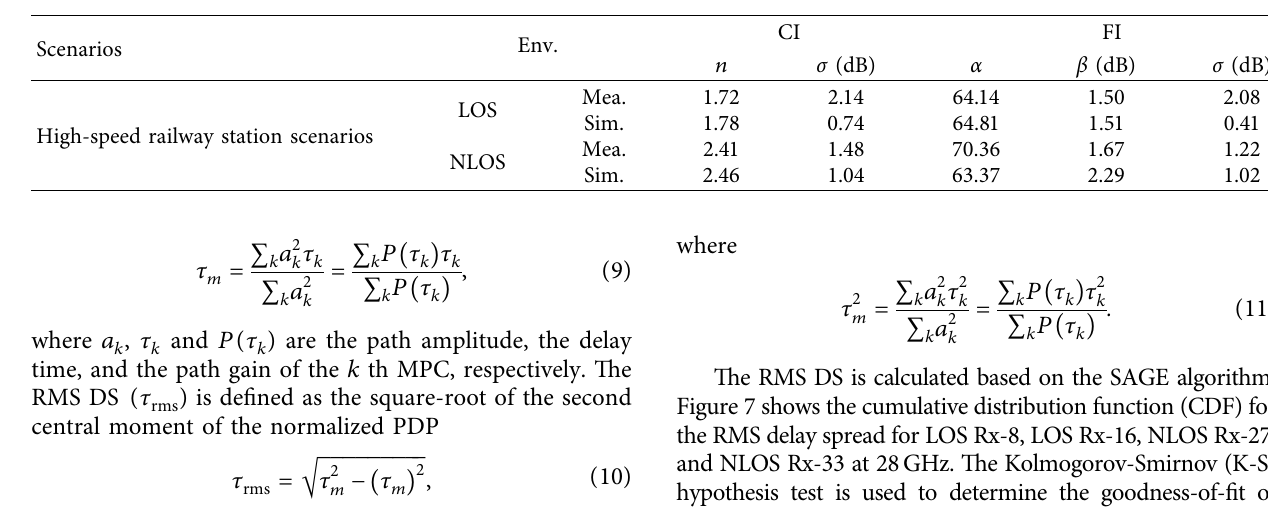
Table 2: Parameters for the CI and FI path loss models in the high-speed railway station scenarios in terms of LOS and NLOS scenarios at